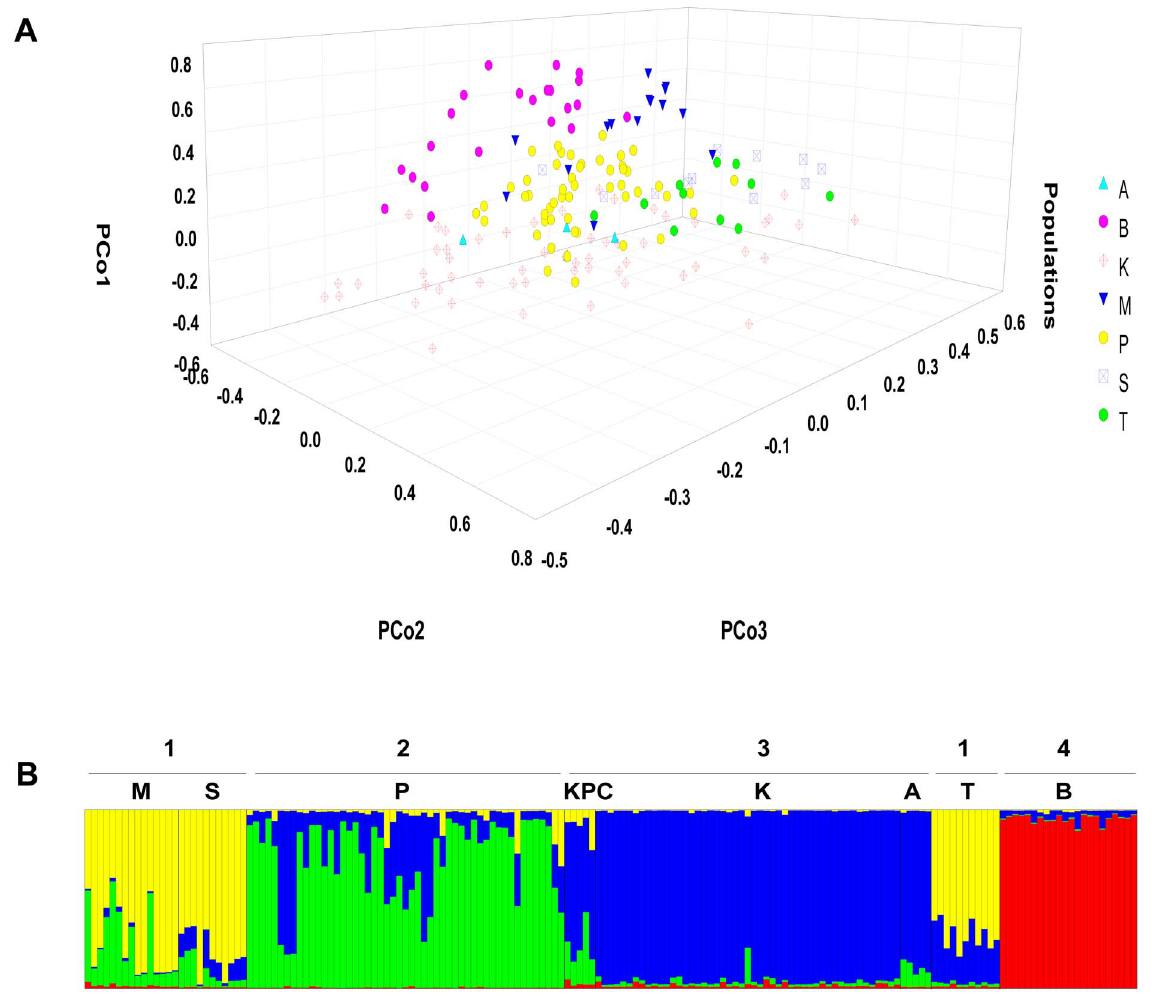
Figure 2. Results of individual clustering analyses. ( A ) Three dimensional plot showing partitioning between different populations as obtained from PCo analysis based on Phi PT co-dominant genetic distance among individuals. ( B ) Summary barplot of STRUCTURE run at K =4 showing population assignments for each individual. Four distinct population clusters are observed. Sampled populations are Melghat (M), Satpura (S), Pench (P), Kanha-Pench corridor (KPC), Kanha (K), Achanakmar (A), Tadoba (T) and Bandhavgarh (B).